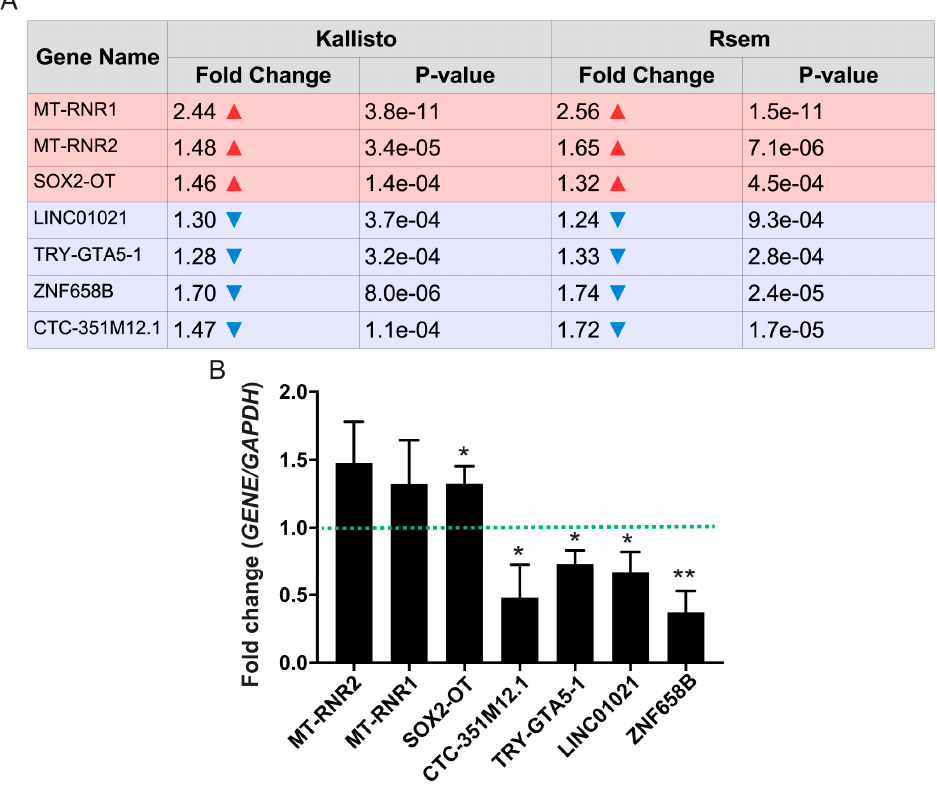
Figure 5. Differential expression of non-coding RNAs (ncRNA) genes between KCl-activated and control iPSC-derived neurons. Differentially expressed ncRNA genes were classified as either upregulated ( MT-RNR1 , MT-RNR2 , and SOX2-OT ) or downregulated ( LINC01021 , TRY-GTA5-1 , ZNF658B , and CTC-351M12.1 ) by neuronal activation. ( A ) Fold-changes calculated based on RNA-Seq data are shown in the table based on both Kallisto-generated and RSEM-generated read counts. In red are the genes that are upregulated in response to neuronal activation, with their respective fold-change (in logarithmic scale) and p -values. The same is shown in blue for downregulated genes. ( B ) Quantitative polymerase chain reaction (qPCR) for all significantly regulated, activity-dependent ncRNA genes predicted by the RNA-Seq results ( n = 5; * p -value < 0.05; ** p -value < 0.01; one-way analysis of variance (ANOVA) with post-hoc Tukey’s multiple comparison test).